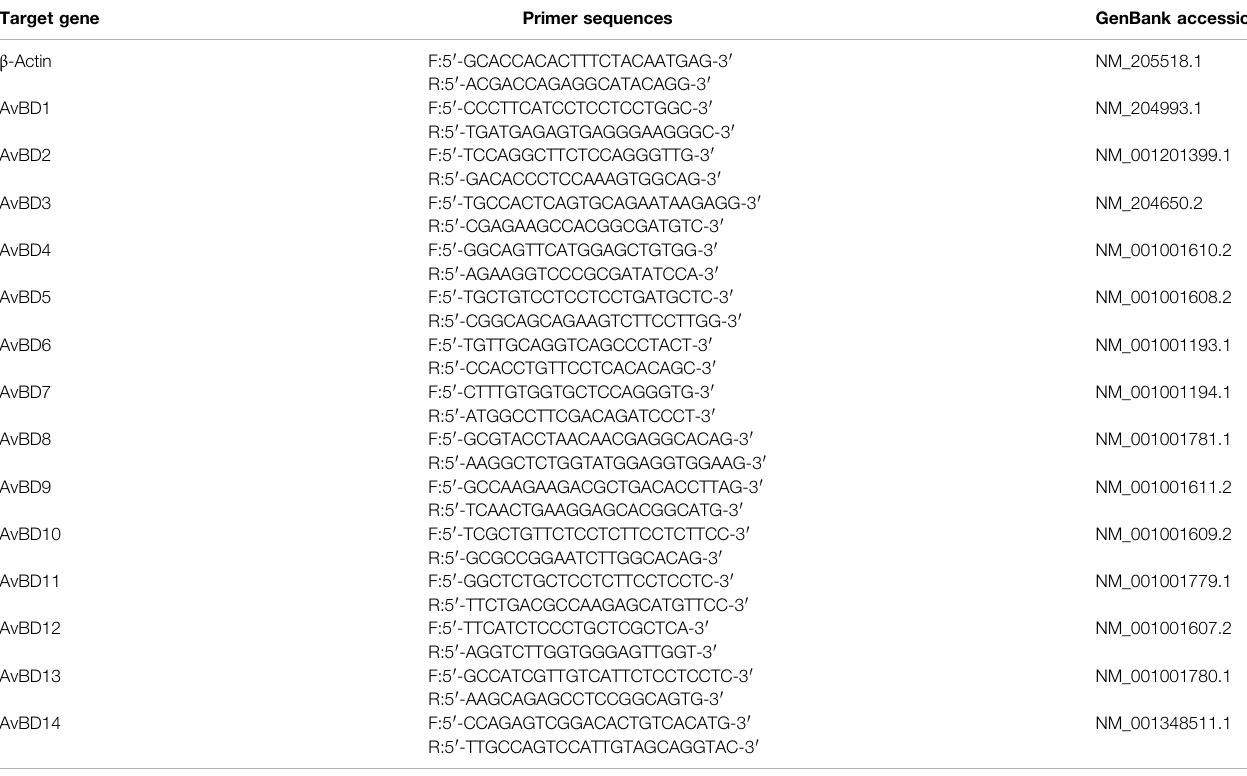
TABLE 3 | Primers of genes related to avian beta-defensins used for mRNA expression.